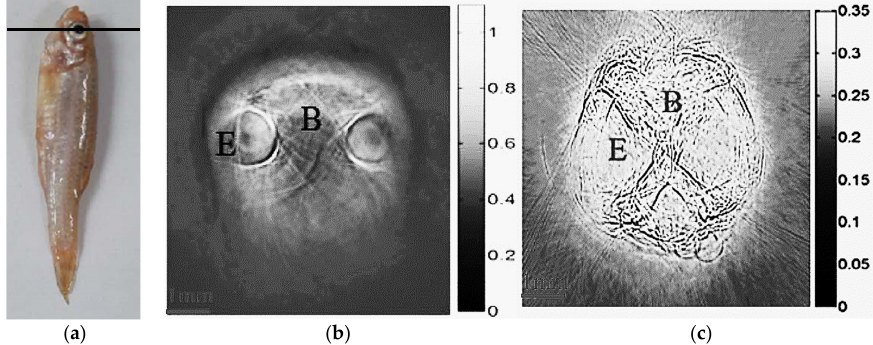
Figure 4. ( a ) The photograph of the adult zebrafish, in which the black line denotes the imaging slice of the zebrafish. The PA images were recovered using a 10 MHz unfocused transducer ( b ) and a focused one ( c ). Here, E represents the eye and B denotes the brain. The gray scale (right) records the PA signals in a relative unit, whereas the color scale (right) illustrates the spatial scale, in mm.